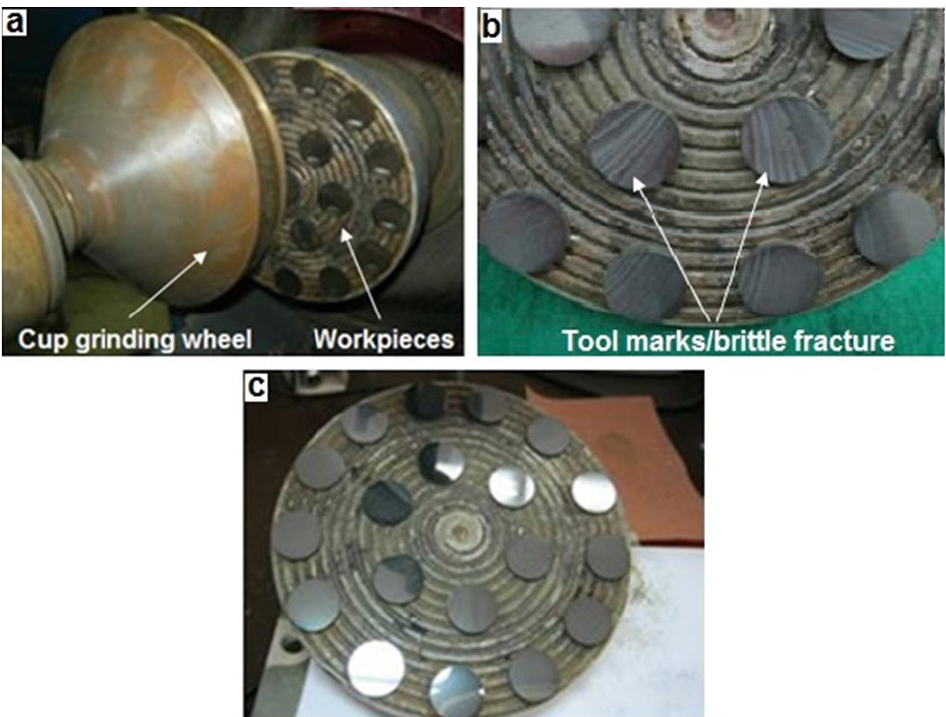
Figure 7. Photos of the aluminum plate with attached α-SiC workpieces a) before grinding, and after grinding for (b) 2 hours, and (c) 6 hours.